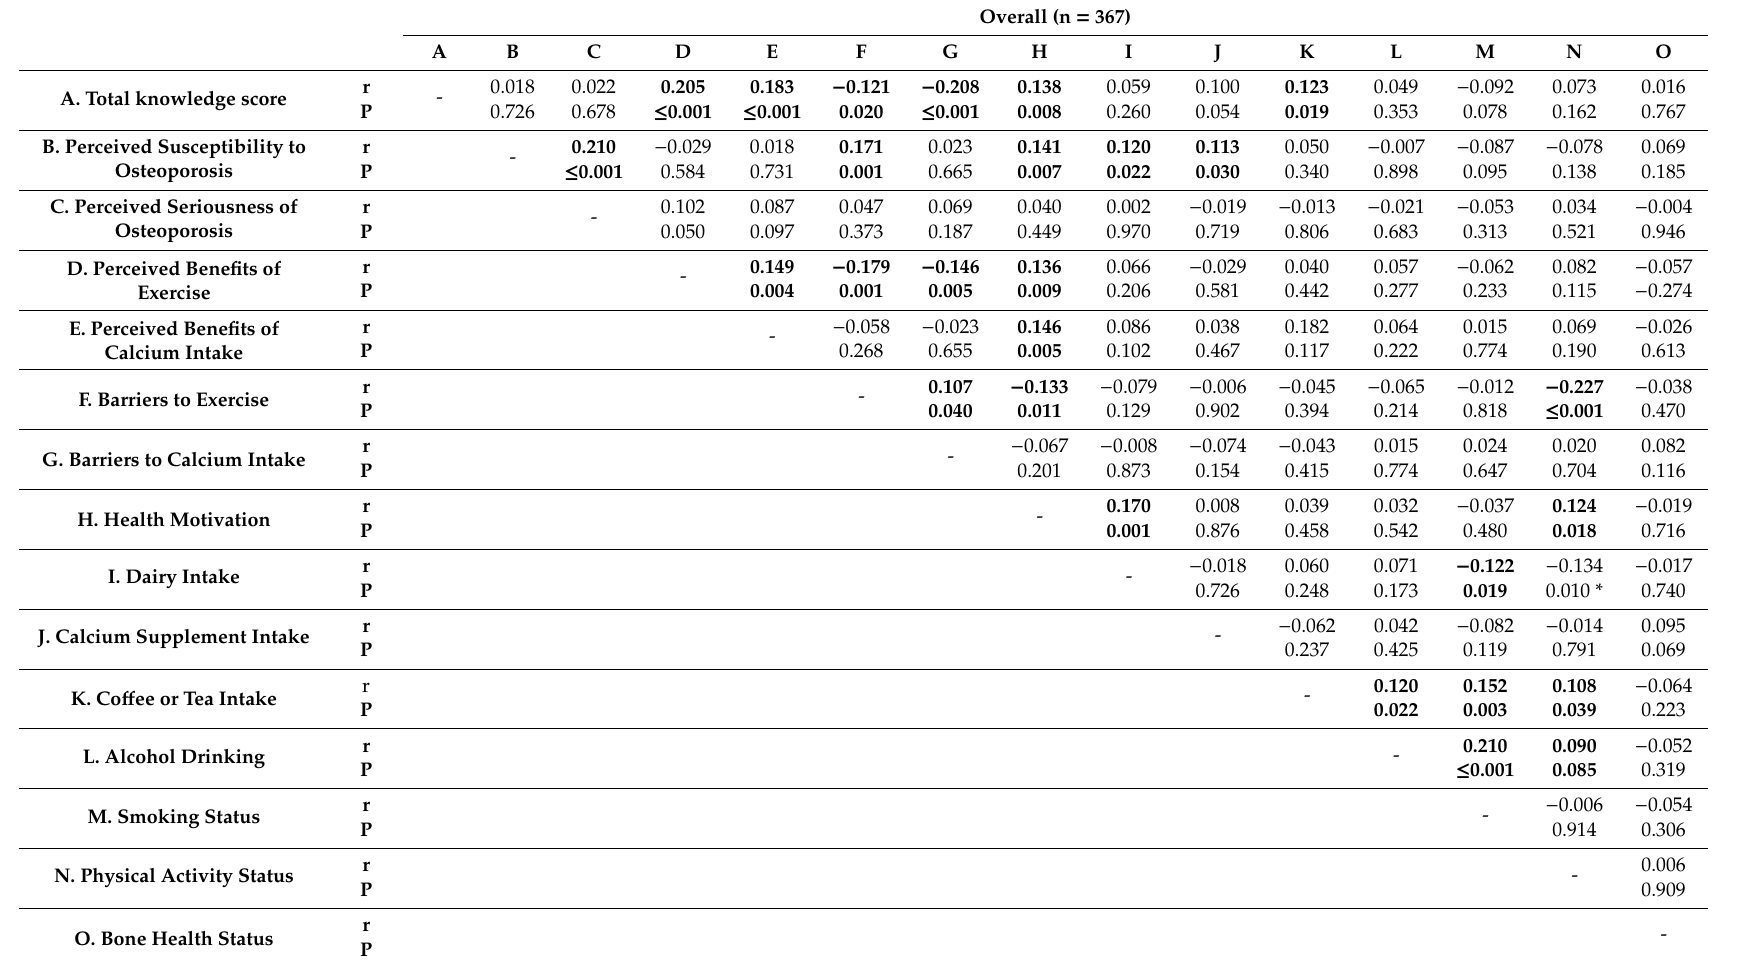
Table 5. Correlation between osteoporosis knowledge, health beliefs, dietary and lifestyle practices, and bone health status (n = 367).